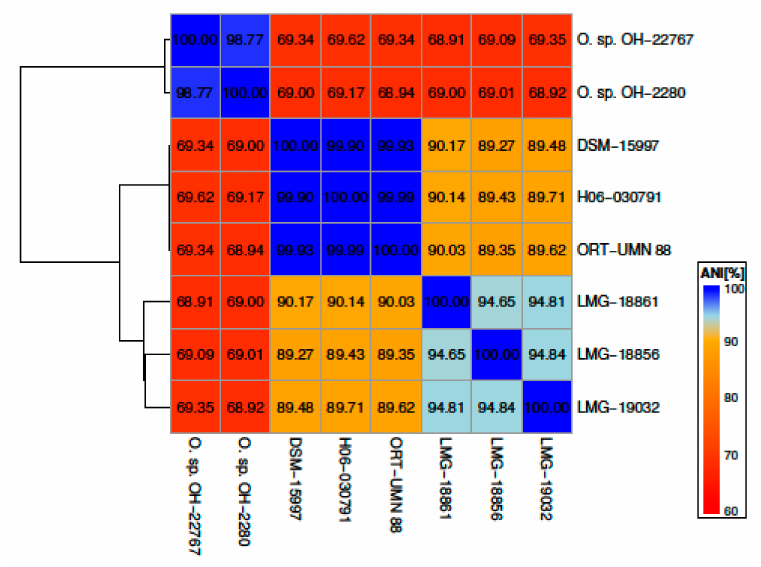
Figure 3. Heatmap of pairwise Average Nucleotide Identity (ANI) between the sequenced O. rhinotracheale and Cand. O. hominis ( O. sp. OH-22767 & OH-2280 ) strains calculated using OrthoANI. ANI values are given in percent, the dendrogram on the right shows a simple hierarchical clustering on (1-ANI) using mean